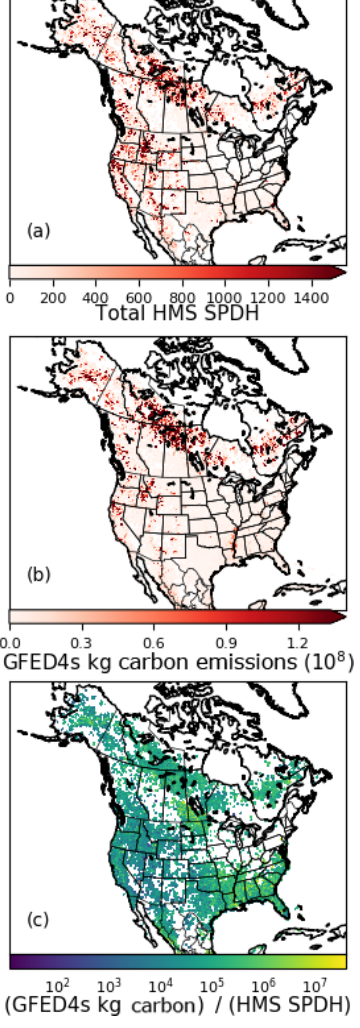
Figure 3. (a) Cumulative June–September 2007–2014 HMS smoke production duration hours (SPDH) and (b) GFED4s kilograms of carbon per 0.25 ◦ × 0.25 ◦ grid cell. Both emission inventories’ color bars saturate (darkest red) at the 99th percentile of non-zero val- ues, meaning all values above the 99th percentile value for both datasets are represented by the darkest color on the color bar. (c) To- tal GFED4s kilograms of carbon emitted divided by the total HMS smoke production duration hours per grid cell for months June– September 2007–2014. The color bar shows the values on a log 10 scale, where yellow values represent grid cells with more GFED4s kilograms of carbon per HYSPLIT point smoke production dura- tion hour, and purple values indicate fewer. Locations where either GFED4s or HMS emissions are equal to zero are not plotted. The mean kilograms of carbon per HYSPLIT Point smoke production duration hour is 300123.